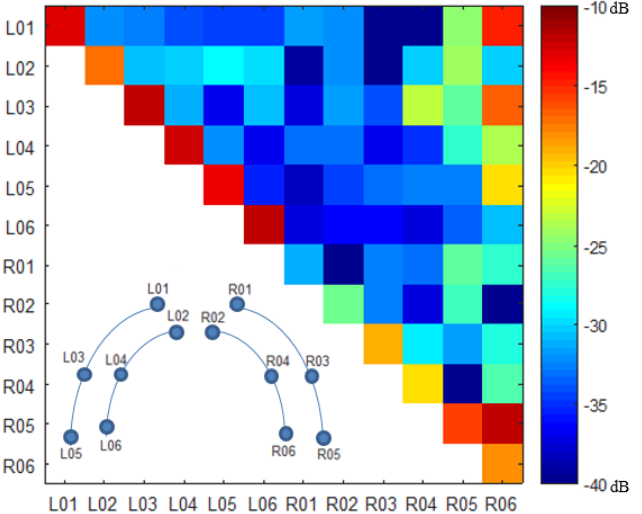
Figure 3. S − matrix and a schematic showing the antenna locations using fish-eye perspective for clarity.